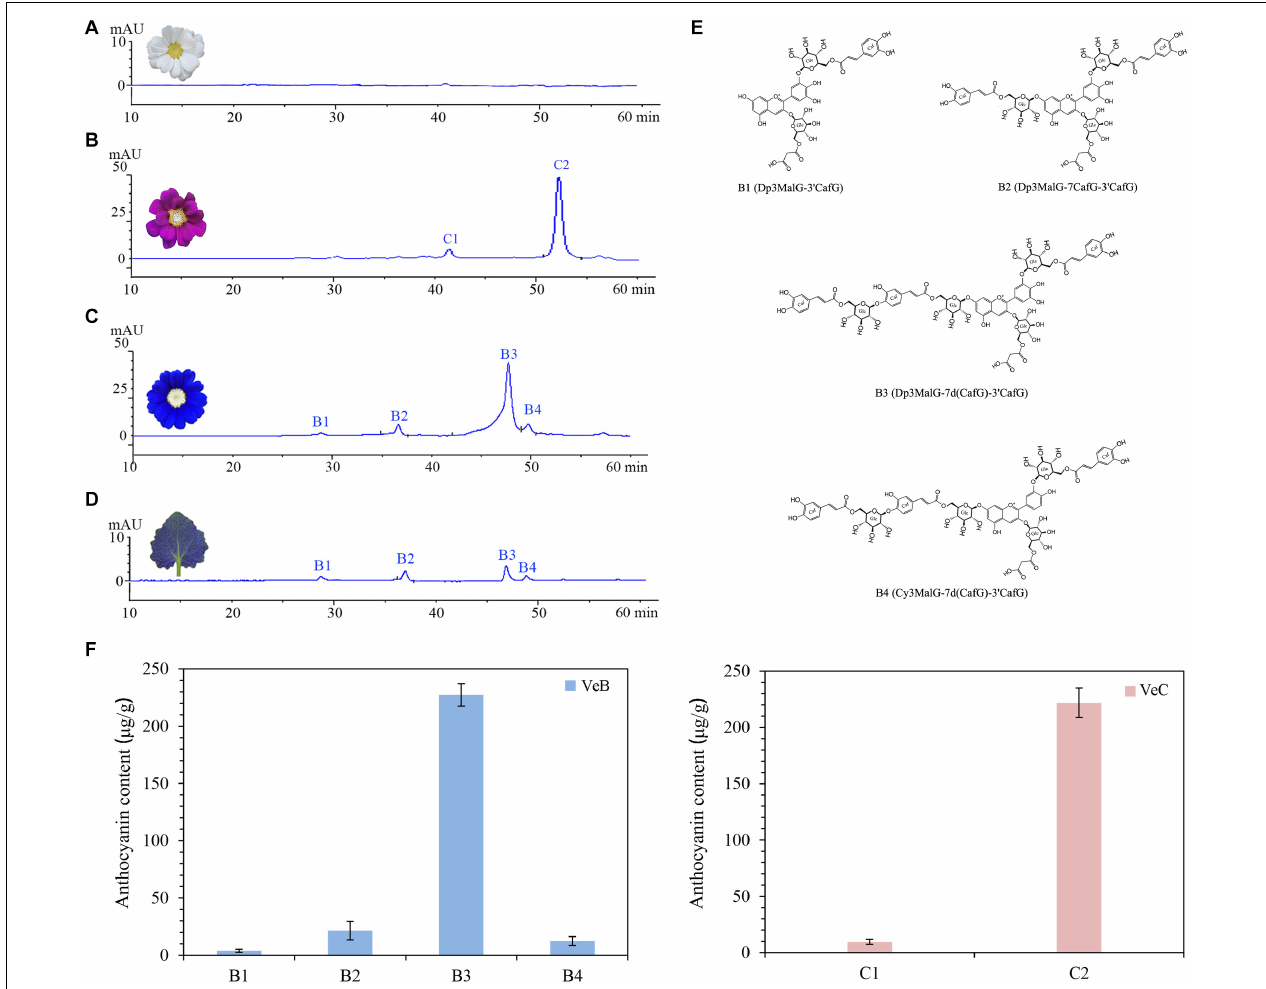
FIGURE 2 | High-performance liquid chromatography (HPLC) analysis (520 nm) of anthocyanin components in the ray florets of VeW (A) , VeC (B) , and VeB (C) . (D) Anthocyanin composition analysis of the leaves of VeB. (E) Hypothetical chemical structures of B1, B2, B3, and B4 peaks. (F) The content of anthocyanins in the ray florets of VeB and